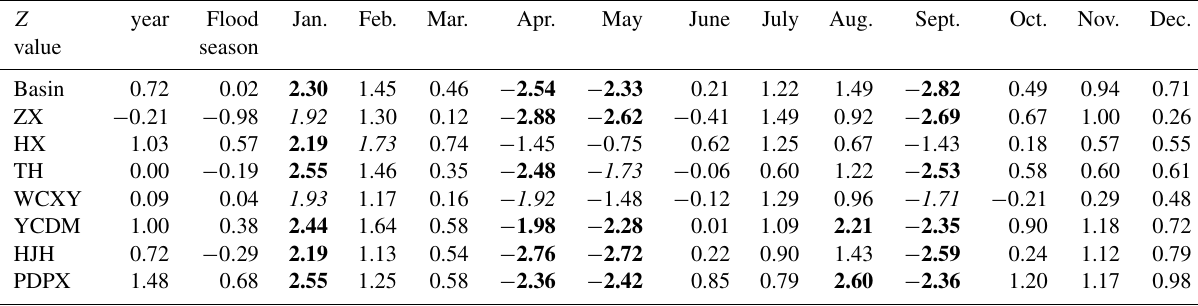
Table 1. Tendencies analysis of precipitation over Taihu basin from 1954 to 2015. Z year Flood